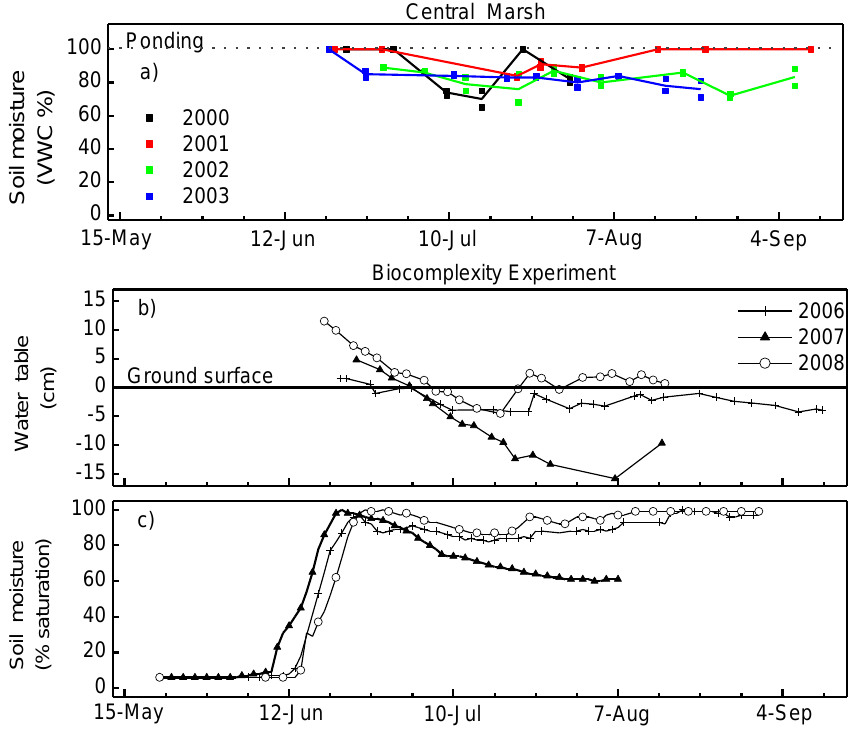
Fig. 2. The soil water status during the study period (no measurements from 1999) at the CM site (a) and the BE site ( b and c ). Panels (a) and (b) represent multiple locations across the vegetated, drained lake basins, while panel (c) is a continuous record of volumetric soil water content measurements at 10cm depth near the BE eddy covariance tower, converted into % saturation.